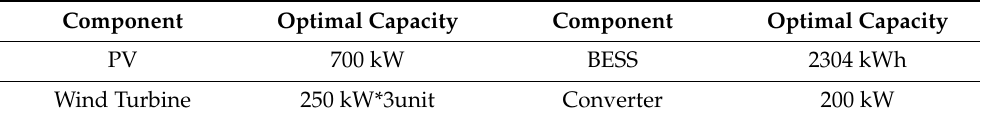
Table 8. Microgrid composition of topology_B under S2.